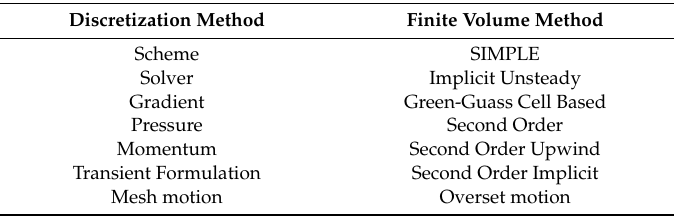
Table 3. Numerical simulation methods.